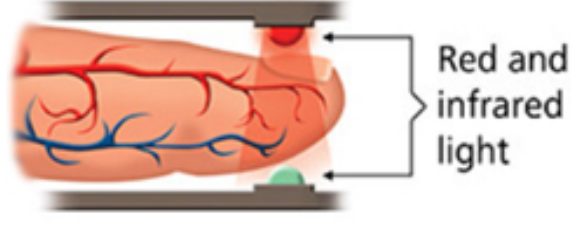
Fig. 2. The Oximeter Sensor Method of Works